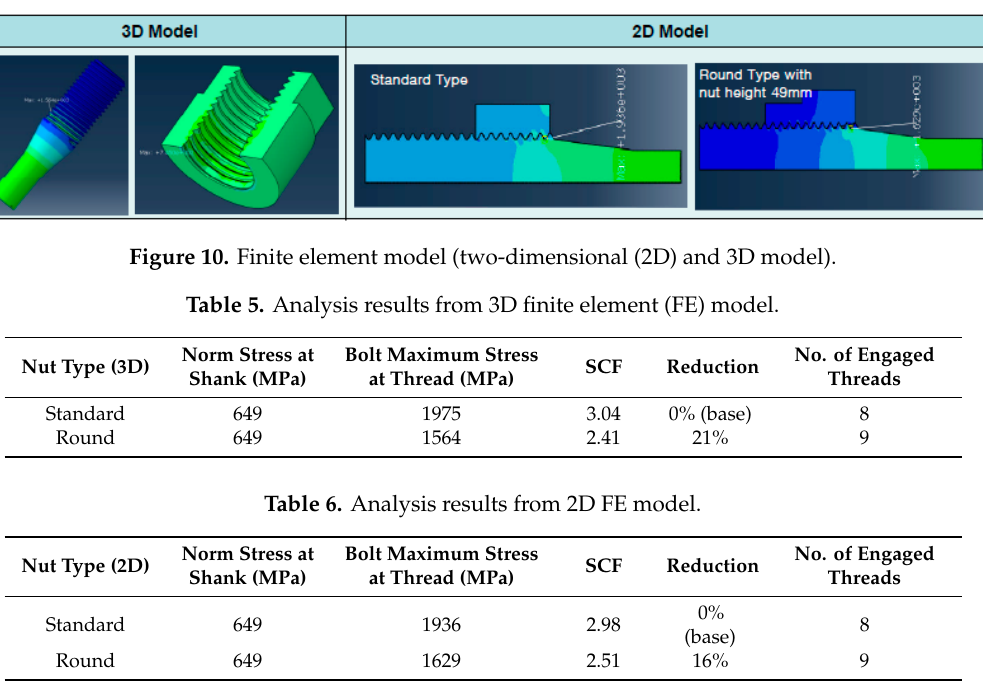
Figure 9. Nut type (standard nut and round nut).